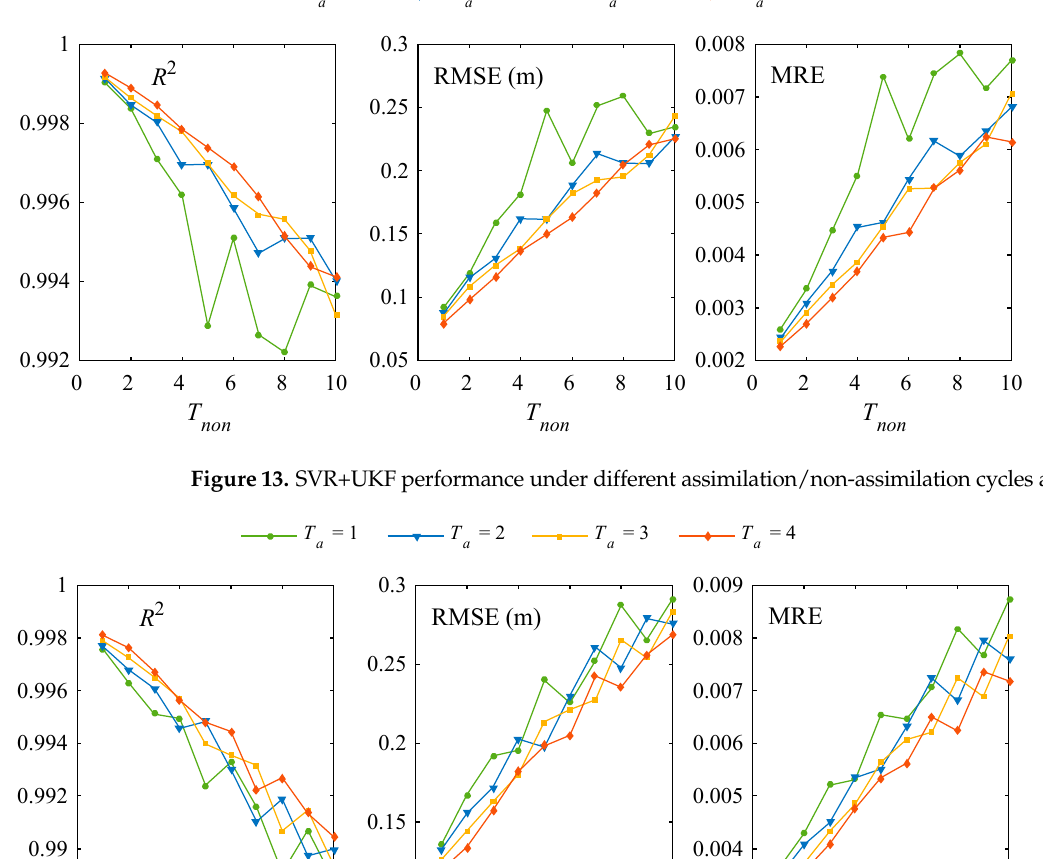
Figure 15. SVR+UKF performance under different assimilation/non-assimilation cycles at Xiaohezui. Another indicator that is vital for water level prediction is the prediction lead time, which enables management to make decisions in advance. For each day of the model application period described above,